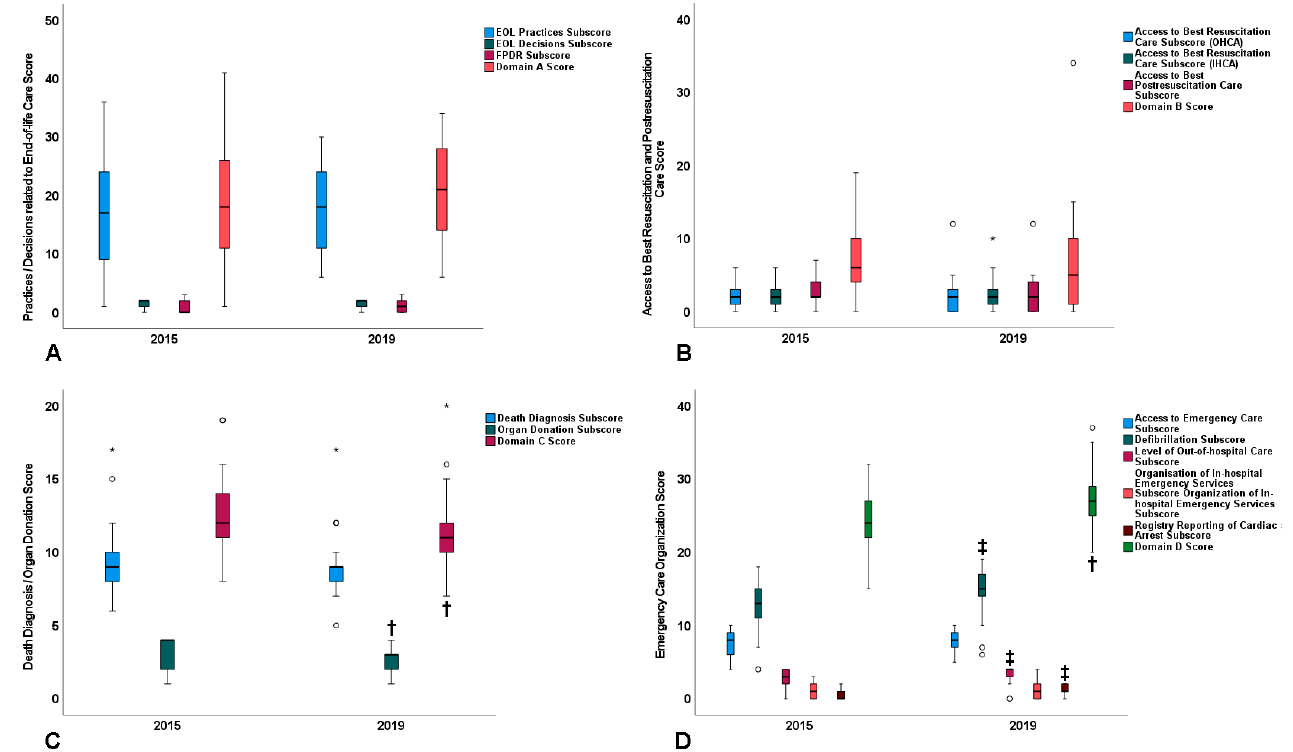
Figure 2. Summary results on the primary study outcome. Boxplot presentation of subscores and scores of domains ( A – D ) of the study questionnaire. Data originate from the 25 participating countries. Bars reflect median value; box height reflects interquartile range; bars on top or bottom of the boxes reflect actual range of values; symbols (circles and asterisk) reflect countries with outlier score values, that is, score values outside the range that corresponds to box height plus the bars. †, p < 0.05 vs. 2015; ‡, p ≤ 0.01 vs. 2015.